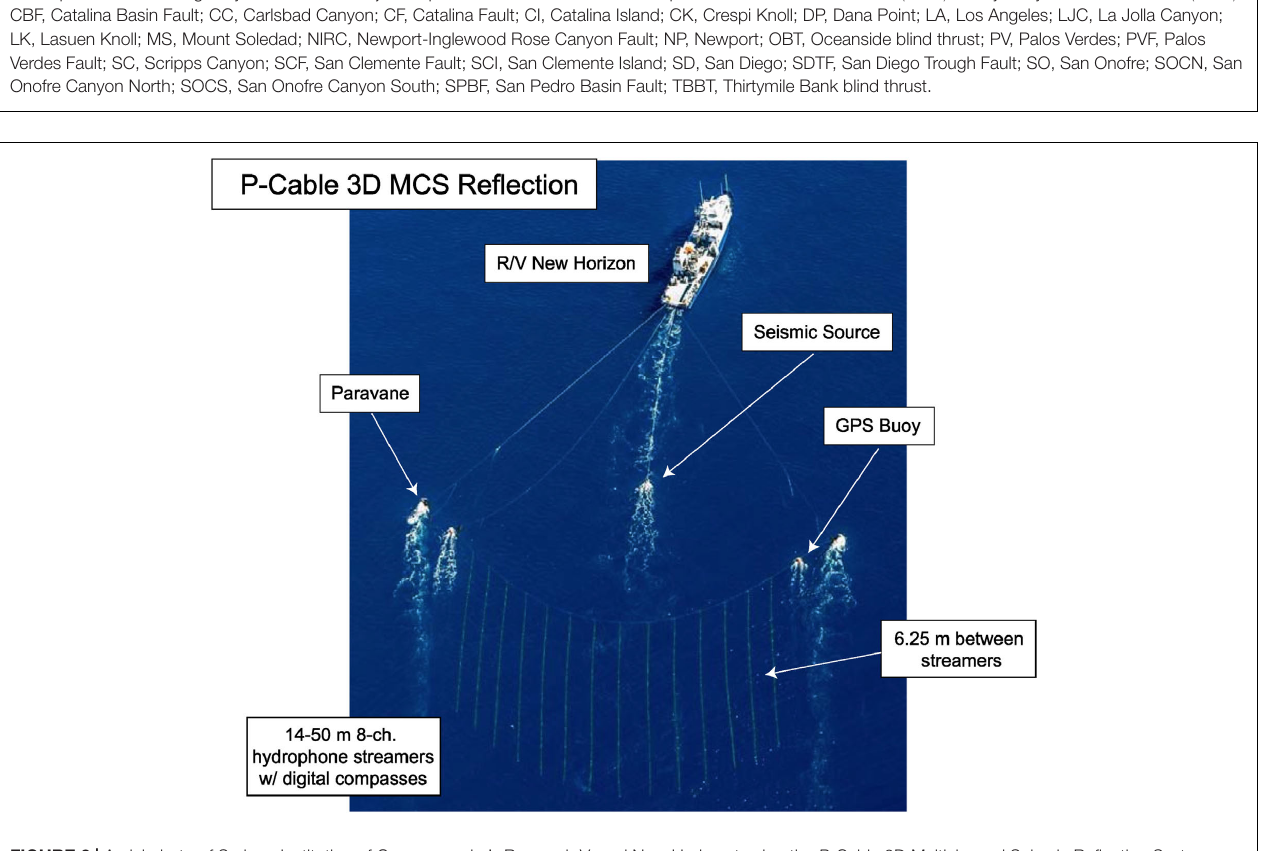
as Costa Rica (Edwards et al., 2018), Japan (Gulick et al.,